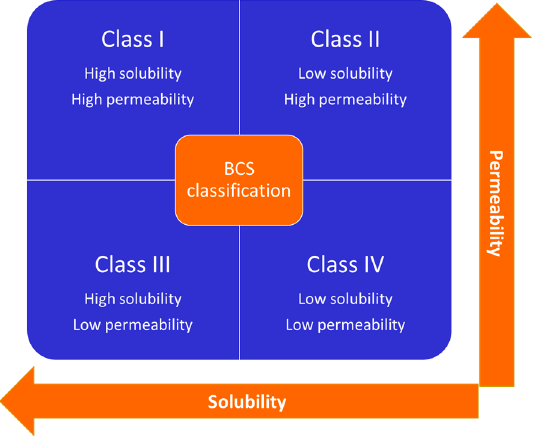
Figure 1. Biopharmaceutical Classification System (BCS) for drugs.